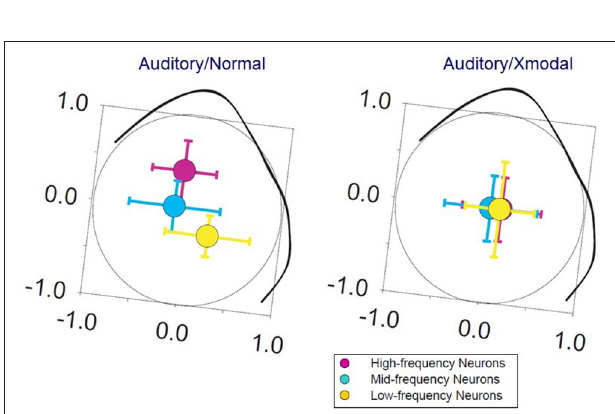
FIGURE 3 | Tonotopic maps in normal ferrets are oriented such that high frequencies are represented medially and low frequencies laterally (left) . In auditory cortex of ferrets in which retinal axons have invaded auditory thalamus, visually-responsive, sound-responsive, and bisensory neurons are intermixed (right) . The tonotopic map in these ferrets is absent, with no significant difference in the spatial center of distribution (colored circles) of high, medium, or low-frequency tuned neurons (error bars indicate ± standard error. Modified from Mao and Pallas, 2012, used with permission).